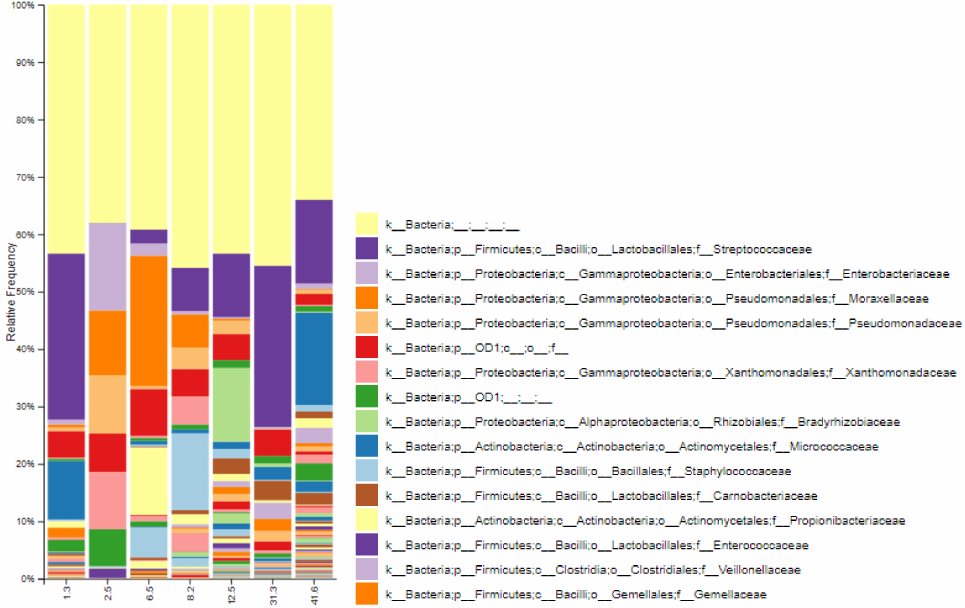
Figure 2. Stacked bar graph showing relative abundances of bacterial families in breast milk of healthy Spanish mothers, determined using 16S rRNA amplicon sequencing. The category axis describes the moment of lactation (in months) of each sample. Due to the large number of reported families, only the first fifteen most abundant families are included in the